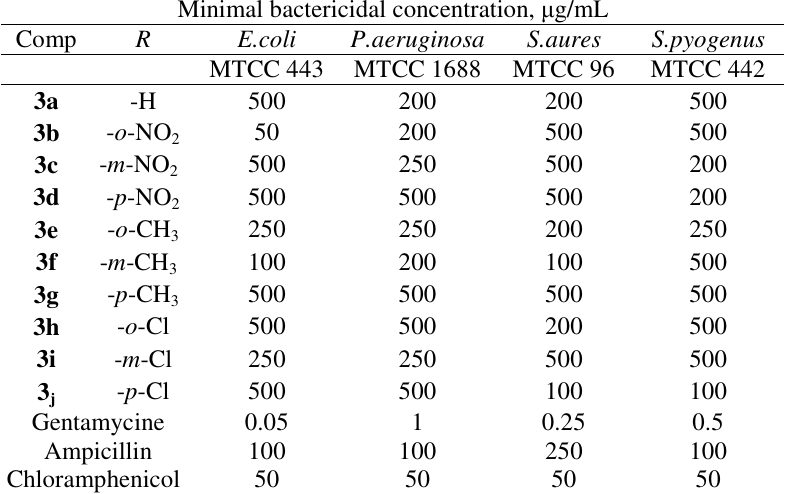
Table 2 . Antibacterial activity of synthesized compounds 3a to 3j